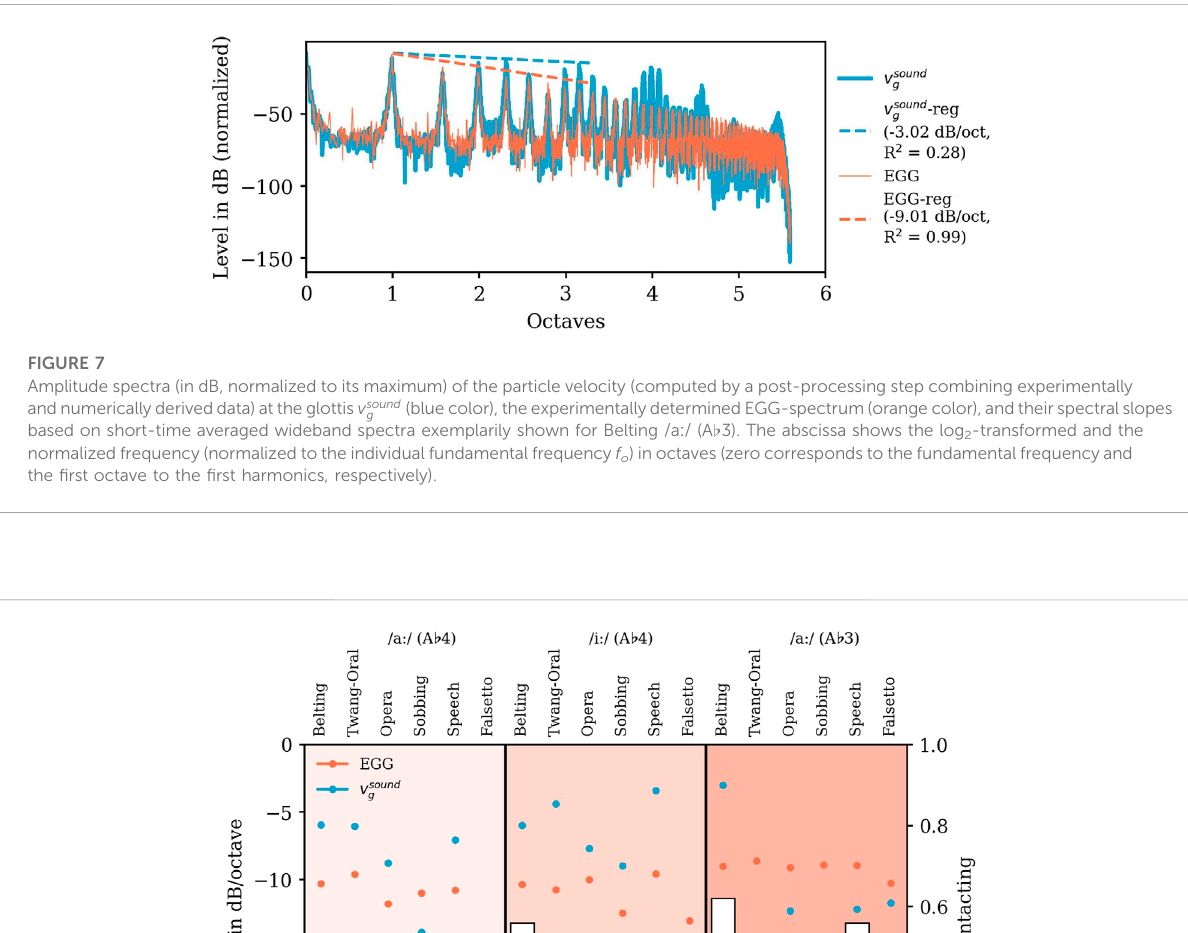
Figure 9 in relation to the respective L eq in orange. To highlight the differences in the previously de fi ned resonance subgroups, we connected these subgroups by lines. Additionally